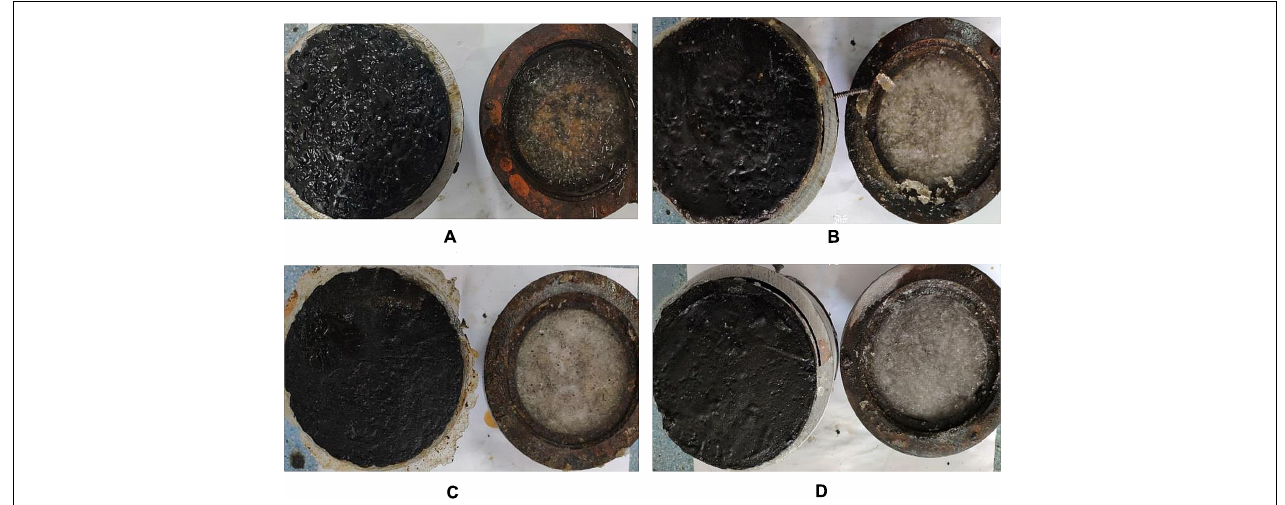
FIGURE 7 | The interface of the AEAB-coated specimens after ice-road adhesion tests: (A) − 5 ◦ C. (B) − 10 ◦ C. (C) − 15 ◦ C. (D) − 25 ◦ C.